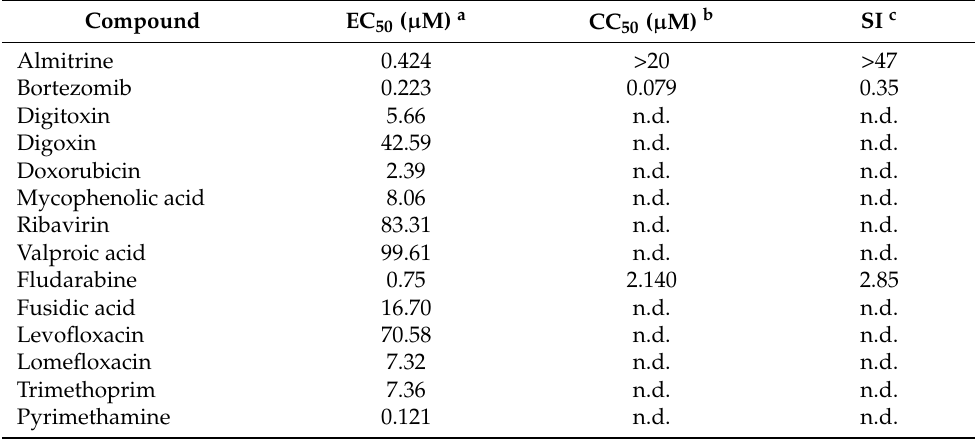
Table 2. In vitro activity of the selected compounds against T. gondii , with pyrimethamine as the reference